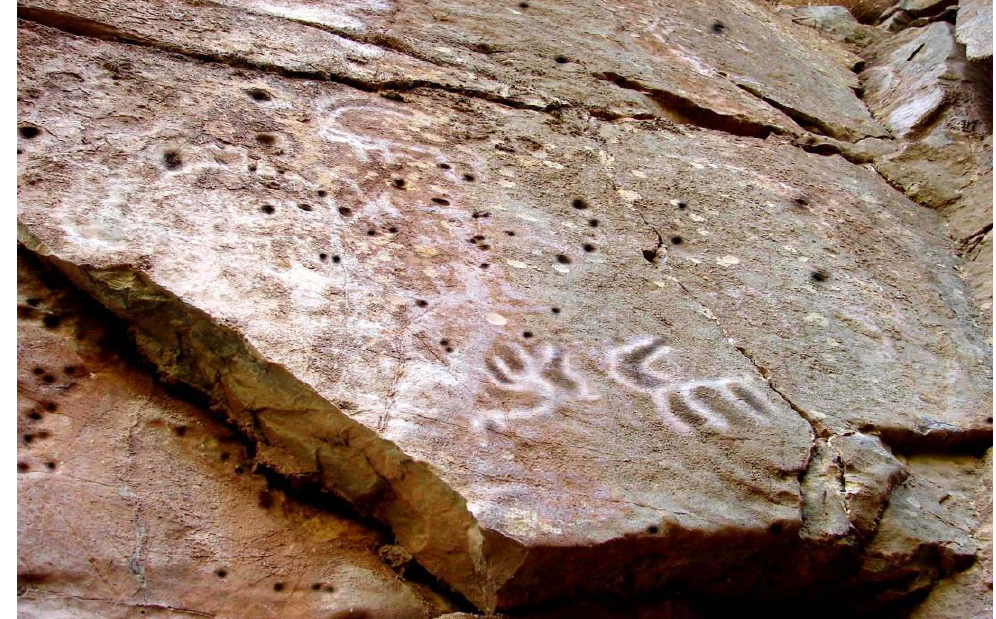
Figure 2. Images of horned animals and cupules on the vertical surface of Bi-Ravascliff at a height of 5 m.